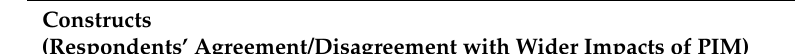
Table A3. Wider impact of participatory irrigation management